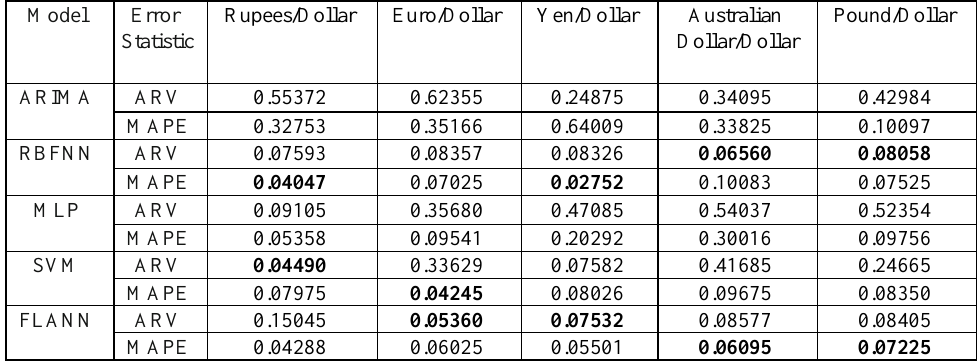
Table 5 Performance of individual models on five exchange rate series